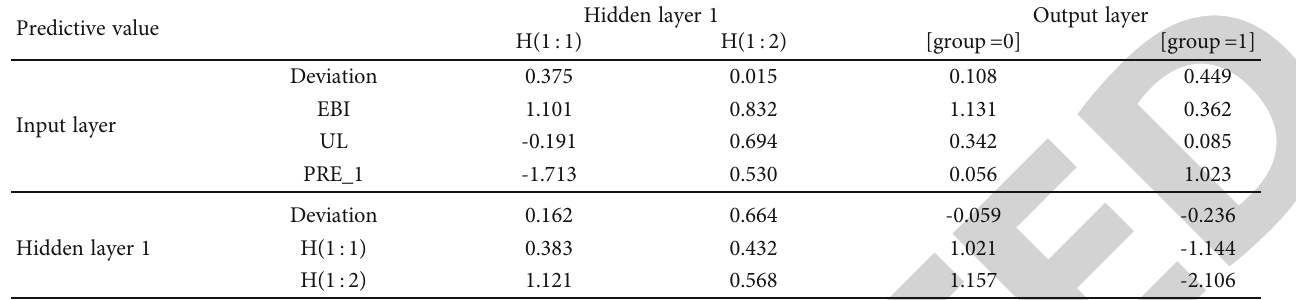
Table 1: Parameter estimation of neural network complex model.